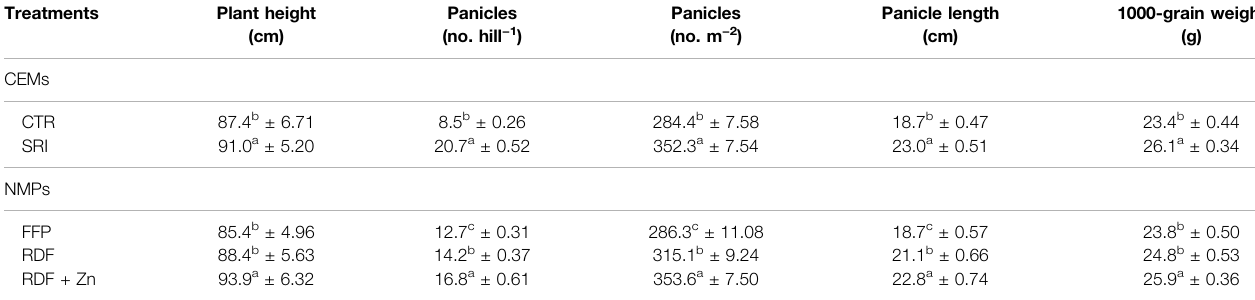
TABLE 3 | Effect of different crop establishment methods (CEMs) and nutrient management practices (NMPs) on the growth and yield attributes of rice (4 years av.).